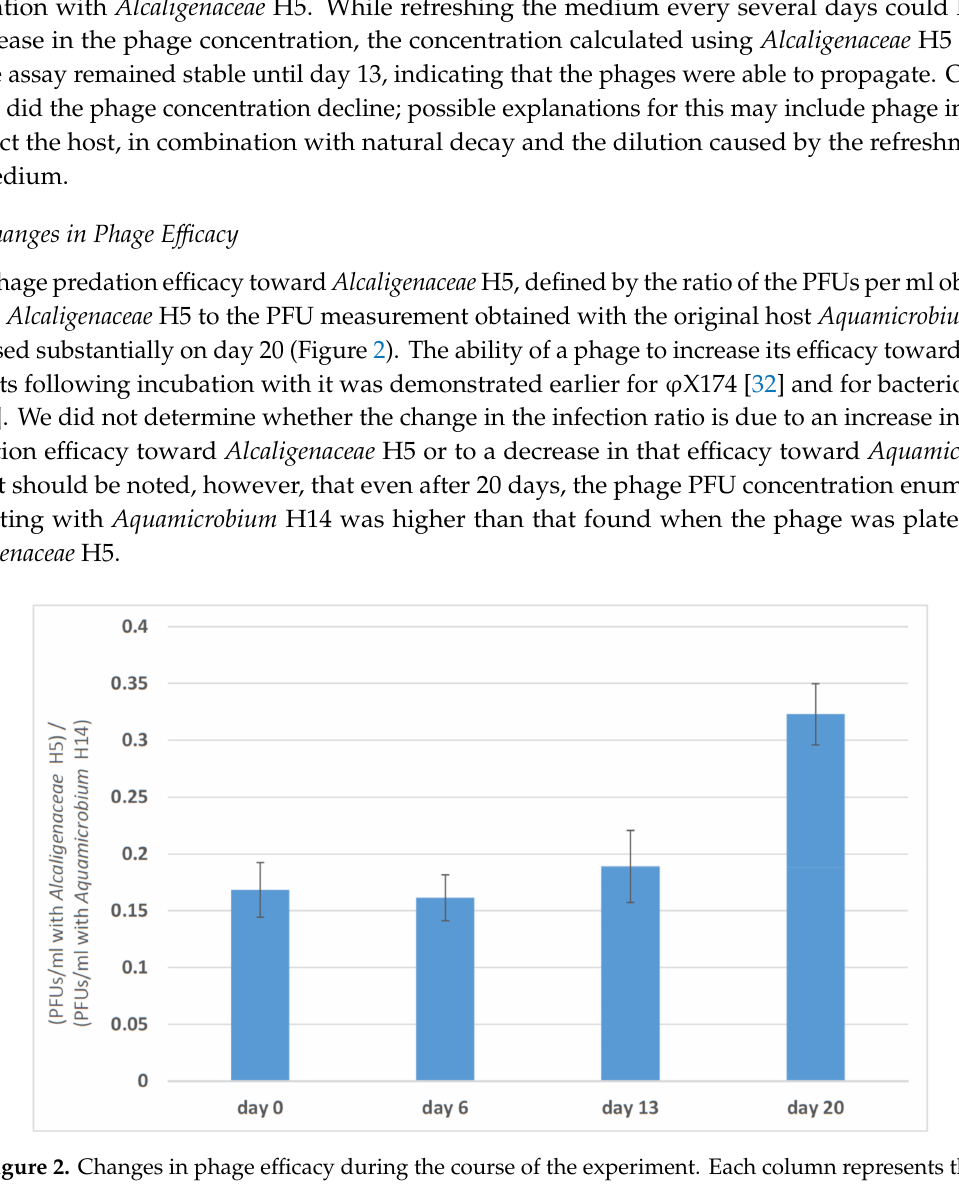
Figure 2. Changes in phage e ffi cacy during the course of the experiment. Each column represents the ratio, at di ff erent time points, between the PFUs / mL of Aquamicrobium phage P14 when enumerated with Alcaligenaceae H5 (three technical replicates) and when enumerated with the Aquamicrobium H14 (three technical replicates). The results are shown as the mean ± standard